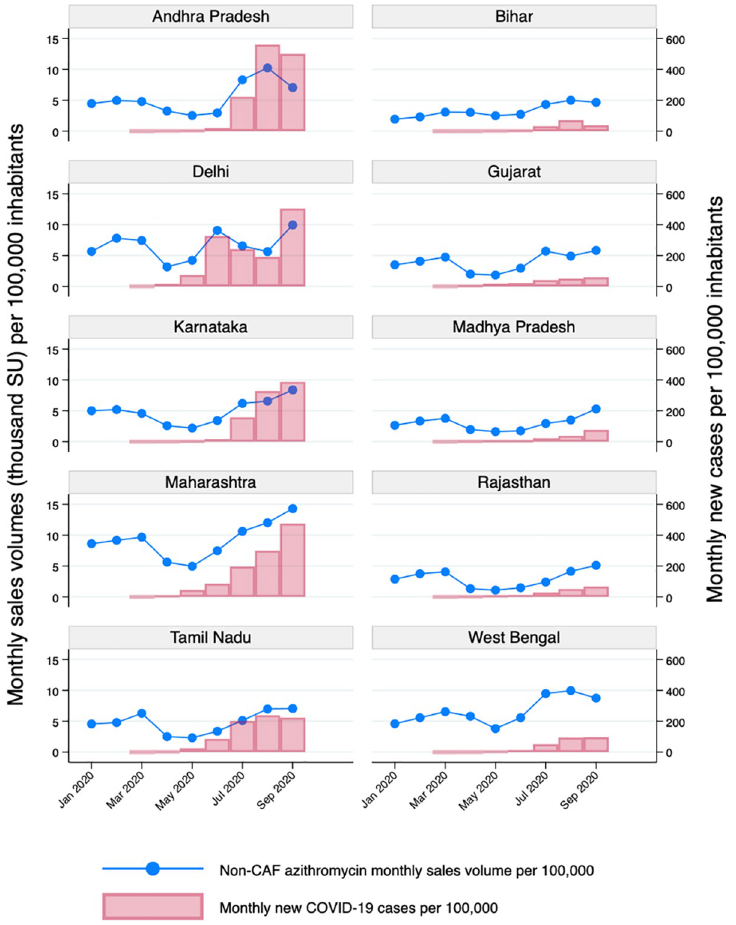
Fig 3. Relationship between new COVID-19 cases per 100,000 (cumulative rate per month) and azithromycin sales volumes per 100,000 population (only non-child-appropriate formulations) in 10 states of India from January to September 2020. States with the highest rates of detected COVID-19 cases are shown on the left side of the graph, whereas states with the lowest rates of detected COVID-19 cases are on the right.